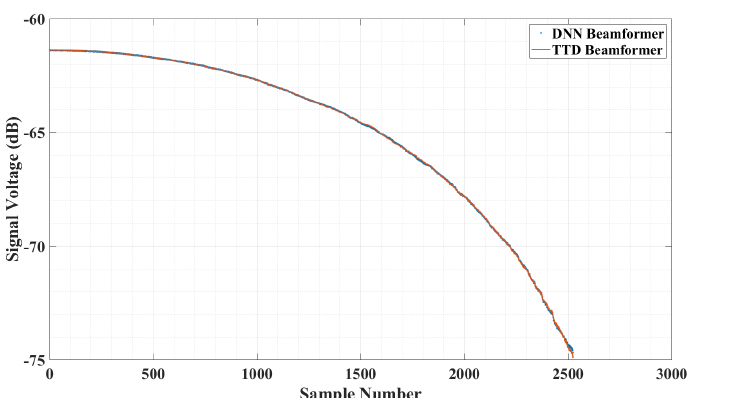
Figure 3. Output signal voltage predicted by the DNN beamformer and that of a true time delay beamformer for the test set at different angle of arrival θ 0 between 0–80 ◦ for the considered frequency range of 99–101 GHz.